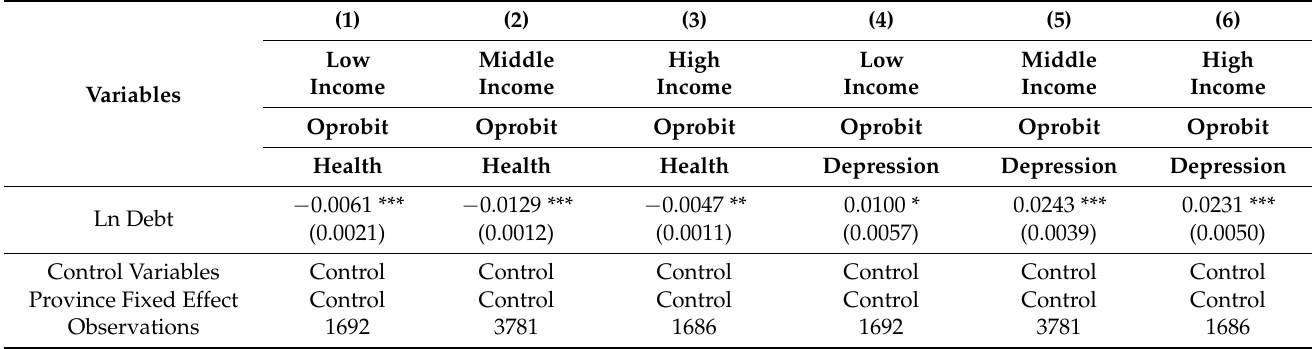
Table 10. Heterogeneity analysis results (income